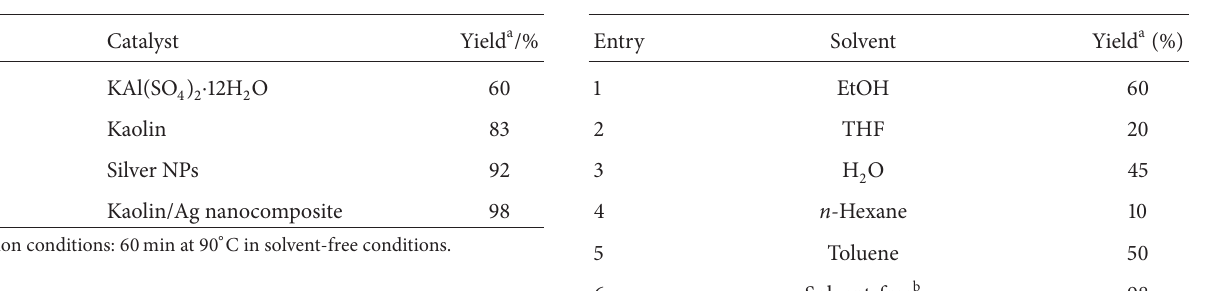
Table 2: Evaluation of the activity of different catalysts for the synthesis of 4a .